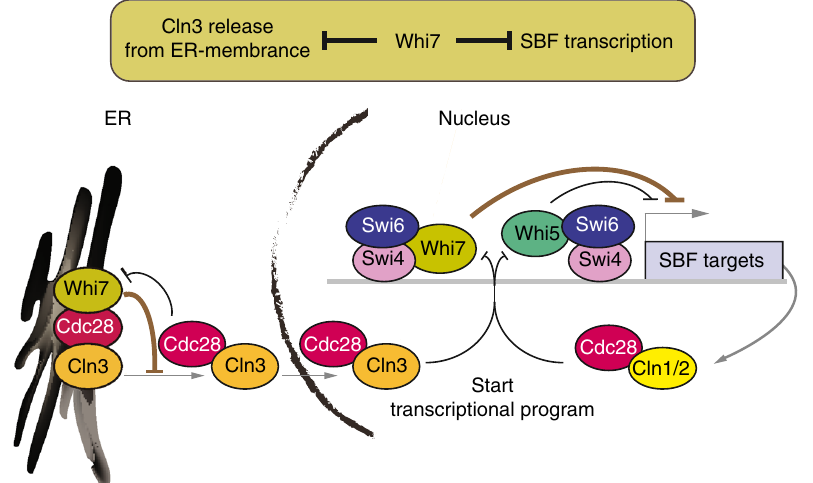
Fig. 8 Model of Whi7 function in the control of Start. Whi7 plays a double repressive role in the execution of Start: it mediates the retention of Cln3 in the endoplasmic reticulum and it collaborates with Whi5 in the repression of SBF-dependent